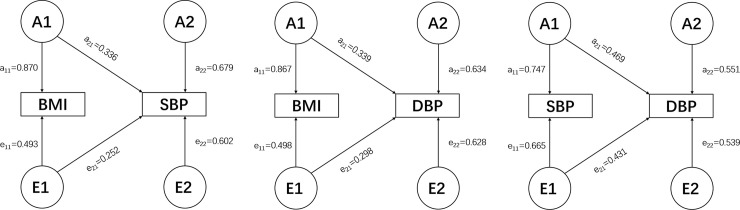
Best bivariate model (AE model) for BMI-SBP (A), BMI-DBP (B), and SBP-DBP (C) with standardized path coefficients. A1, A2: genetic variance components; E1, E2: unique environmental variance components; a11 through a22: genetic path coefficients, of which a22 demonstrates specific genetic influence on BP. e11 through e22: unique environmental path coefficients, of which e22 demonstrates specific unique environmental influence on BP.